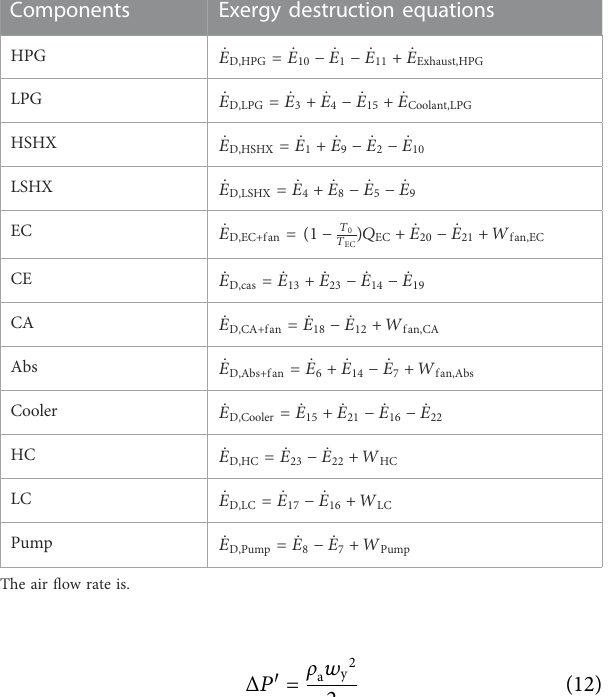
TABLE 2 Exergy destruction equations.